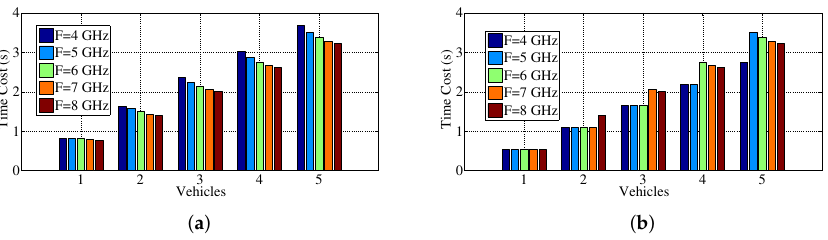
Figure 4. The impacts of the capacity of the VEC server on the time cost. ( a ) γ i , t = 0.2, γ i , e = 0.8; ( b ) γ i , t = 0.5, γ i , e = 0.5.